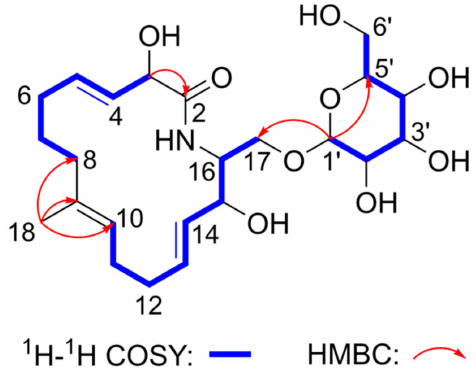
Figure 2. Key 1 H– 1 H COSY and HMBC correlations of 1 .